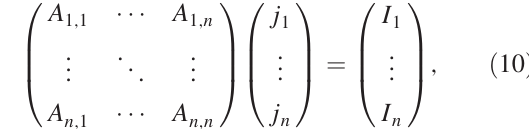
grid cell, the weighting factor equals the overlapping area between the blue quadrilateral and the grid cell. Therefore, for each column in the phase space plot, if the array of angular values are numbered from 1 to n , a system of linear equations can be written down